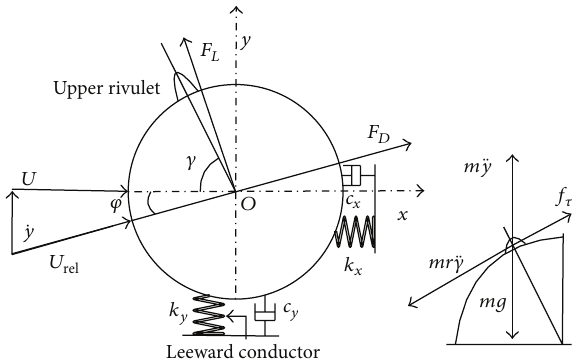
Figure 2: 3DOF vibration model of the leeward conductor.